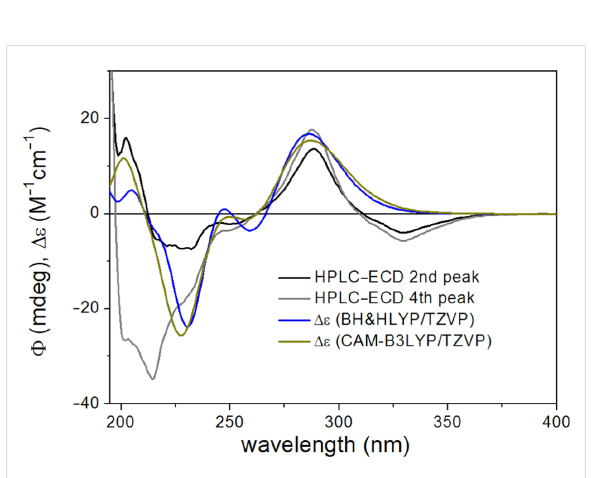
Figure 7: Experimental HPLC-ECD spectra of (2 R ,5’’ S )- 2a (second eluted stereoisomer) and (2 R ,5’’ R )- 2d (fourth eluted stereoisomer) compared with the Boltzmann-weighted ECD spectra computed for the CAM-B3LYP/TZVP PCM/MeCN low-energy conformers of (2 R ,5’’ R )- 2 at various